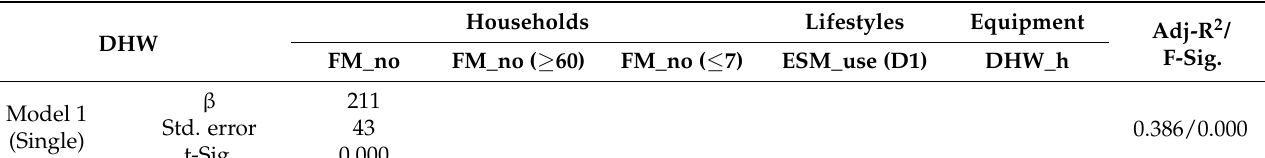
Table 7. Analysis results of valid determinants for DHW.